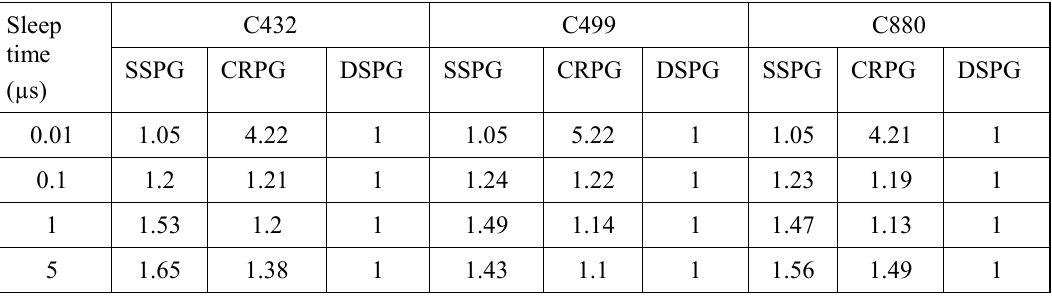
Table 3: Comparison the normalize leakage power loss in ISCAS-85 benchmark circuits when sleep time is from 0.01µs to 5µs at 100 o